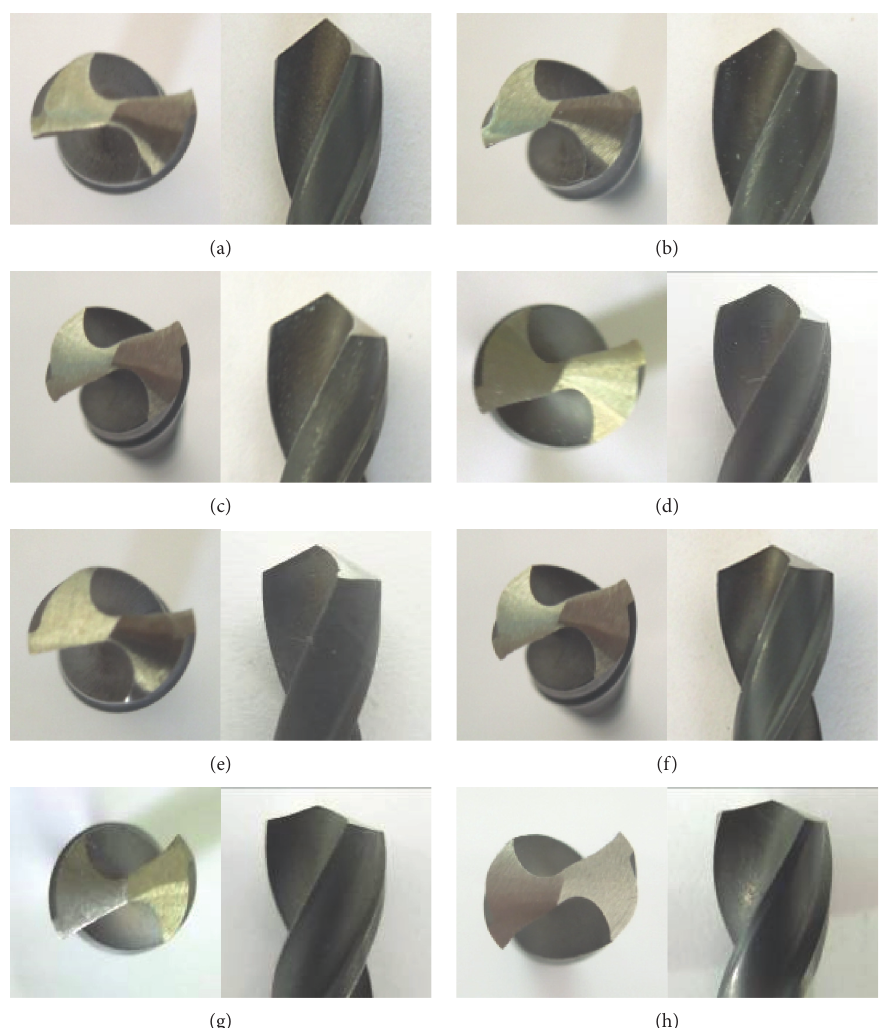
Figure 4: The shape of blade-grinded drills. (a) 2 ϕ � 100 ° . (b) 2 ϕ � 110 ° . (c) 2 ϕ � 115 ° . (d) 2 ϕ � 120 ° . (e) 2 ϕ � 125 ° . (f) 2 ϕ � 130 ° . (g) 2 ϕ � 140 ° . (h) 2 ϕ � 150 °